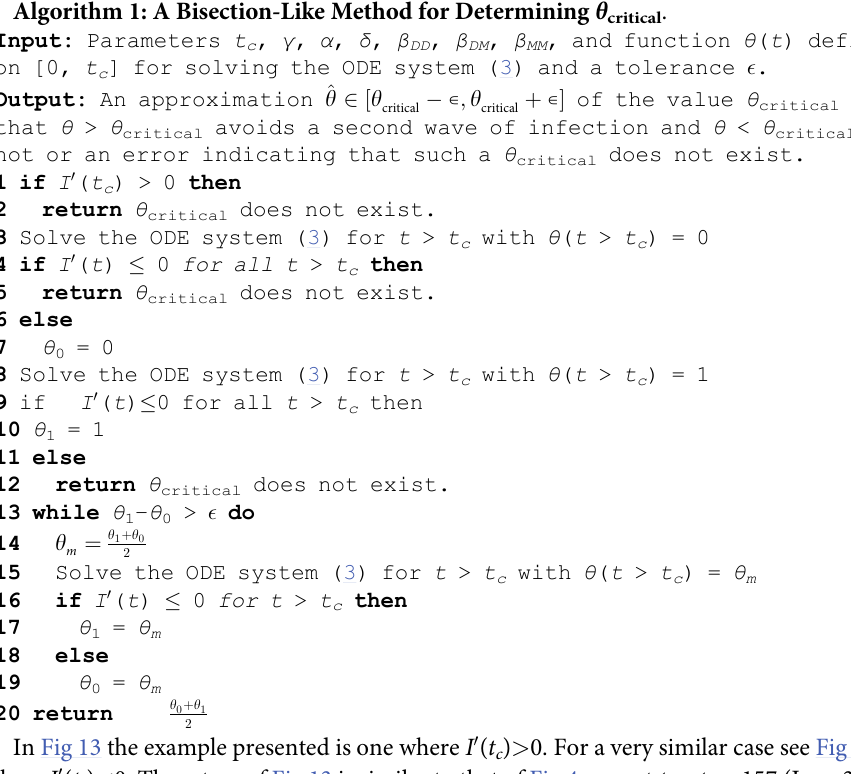
Algorithm 1: A Bisection-Like Method for Determining θ